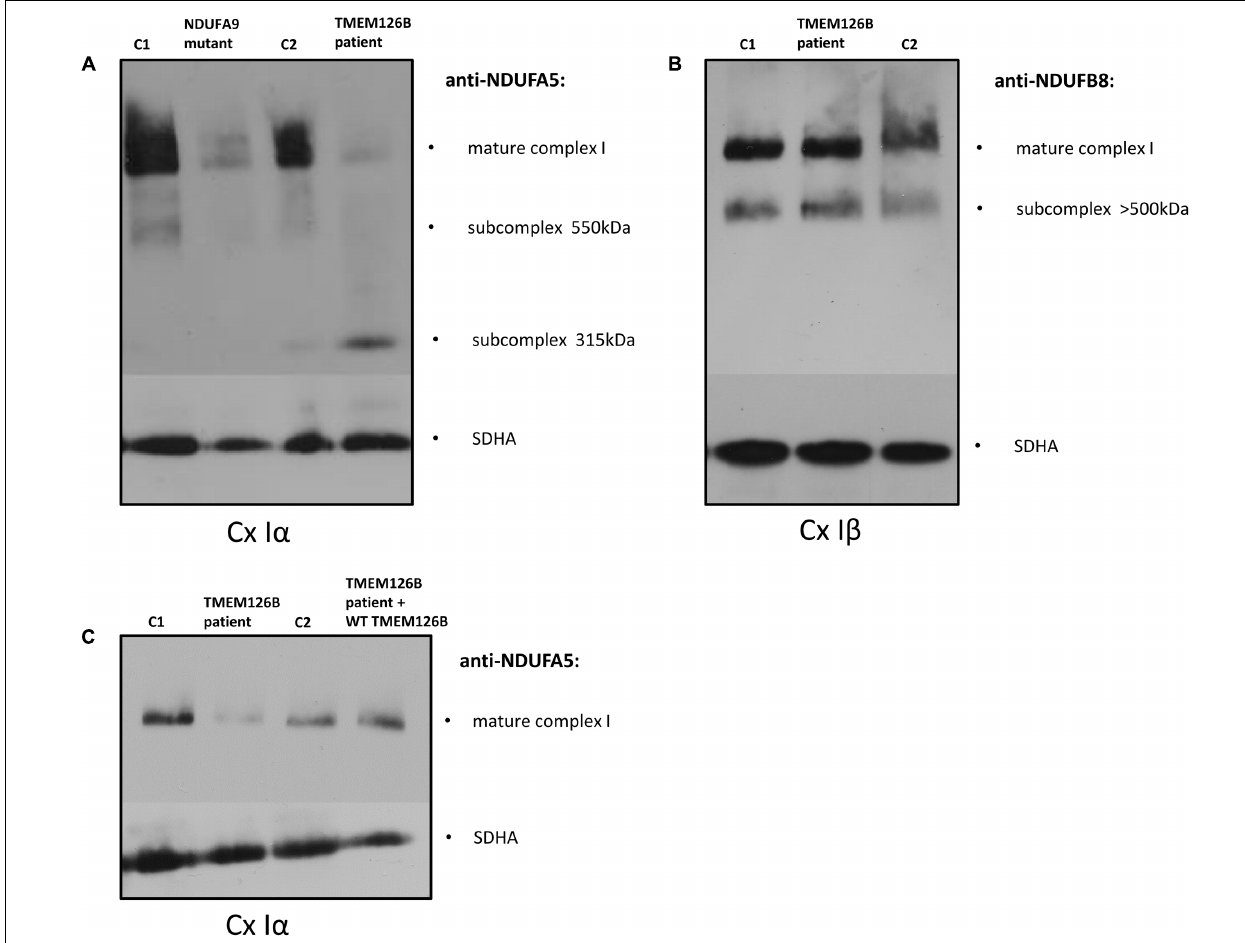
FIGURE 1 | Blue-Native PAGE on fibroblasts of the patient (TMEM126B patient), 2 controls [control 1 (C1), control 2 (C2)] and NDUFA9 mutant. (A) Anti-bodies against NDUFA5 were used to detect mature complex I and assembly intermediates containing the Q module of the peripheral arm of complex I (Cx I α ). A loss of mature complex I and accumulation of the 315 kDa intermediate in the patient indicated impaired complex I assembly. (B) NDUFB8 antibodies detected assembly stages of the membrane arm of complex I (Cx I β ), which showed normal NDUFB8 quantities in mature complex I, suggesting that assembly of the membrane arm (P-module) succeeded despite missing parts of the peripheral matrix arm [ (A,B) are the representatives of two replicates]. (C) Patient fibroblasts (TMEM126B patient) were lentiviral transduced with wild-type TMEM126B (TMEM126B patient + WT TMEM126B) and showed a recovery of the amount of mature complex 1 when compared to healthy control fibroblast (C1 + C2) [ (C) consists of a single experiment].